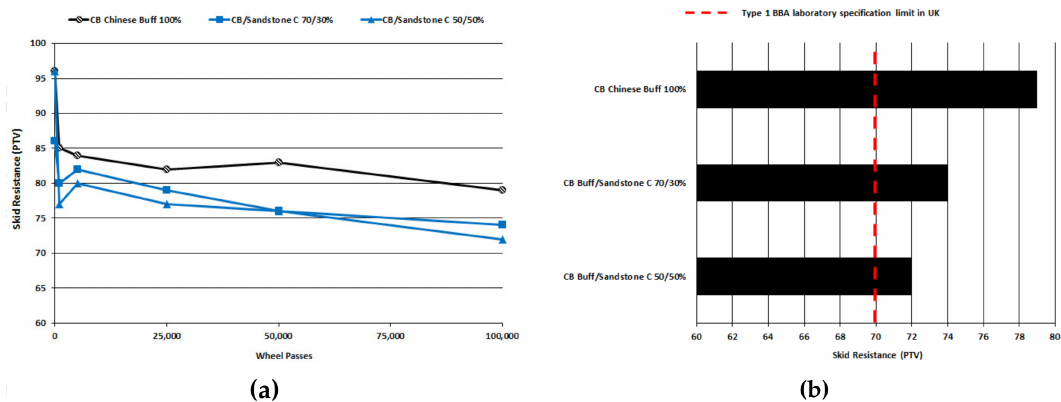
Figure 7. ( a ) Skid resistance development up to 100,000 wheel-passes; ( b ) skid resistance ranking after 100,000 wheel-passes (Ulster University data).